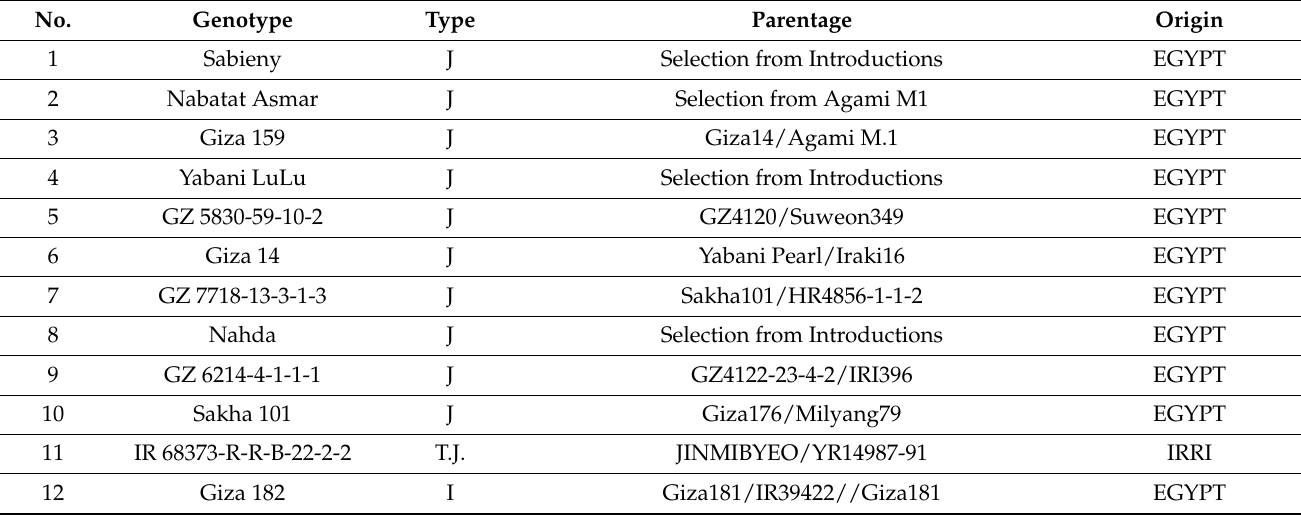
Figure 1. The AMMI1 and AMMI2 ( A , B ), respectively) biplots indicating the GEI for the 55 rice genotypes across 4 N environments. The genotypes’ and environments’ legends are presented in Table 2. Table 2. Name, type, parentage, and origin of the plant